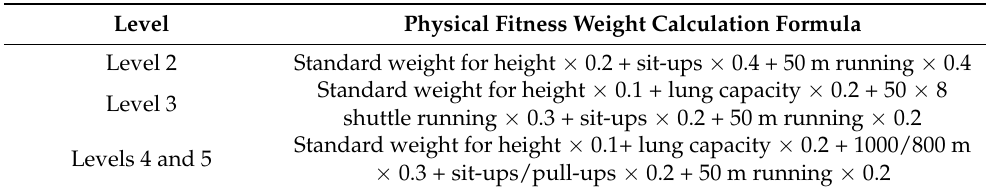
Table 5. The weight calculation table of the total physical fitness scores among students at four